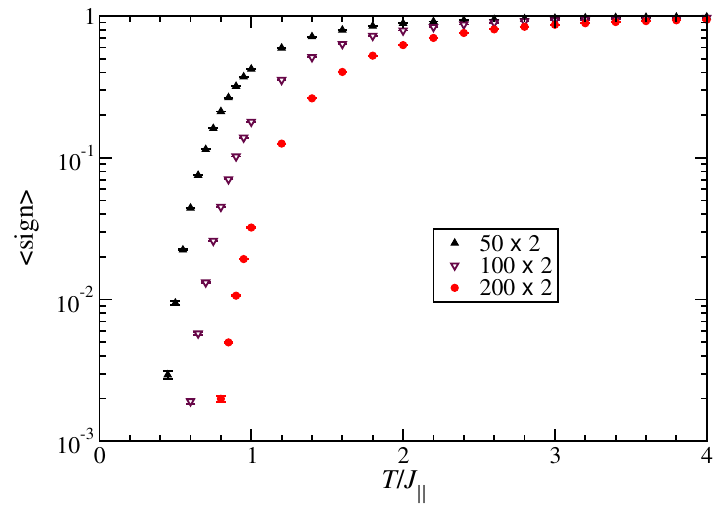
Figure 2: Average sign, 〈 sign 〉 , for a QMC simulation in the single-site basis of the frustrated ladder at J ⊥ = 0.38, J (cid:107) = 1, and J × = 0.196, shown as a function of temperature for ladders with L = 50, 100, and 200 rungs. Analogous results for the rung basis are shown in Fig. 4 and the thermodynamic response, also computed in the rung basis, in Fig. 12.